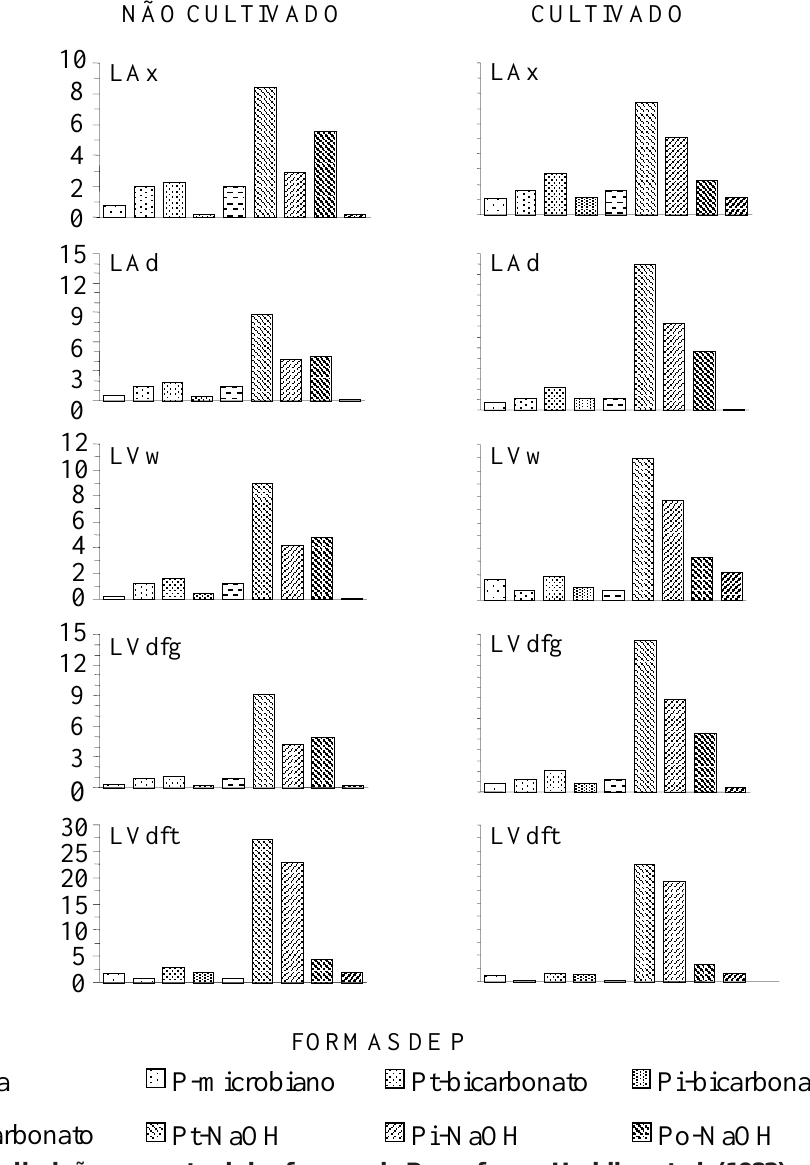
Figura 3. Distribuição percentual das formas de P, conforme Heddley et al. (1982), em relação ao P total, nos solos